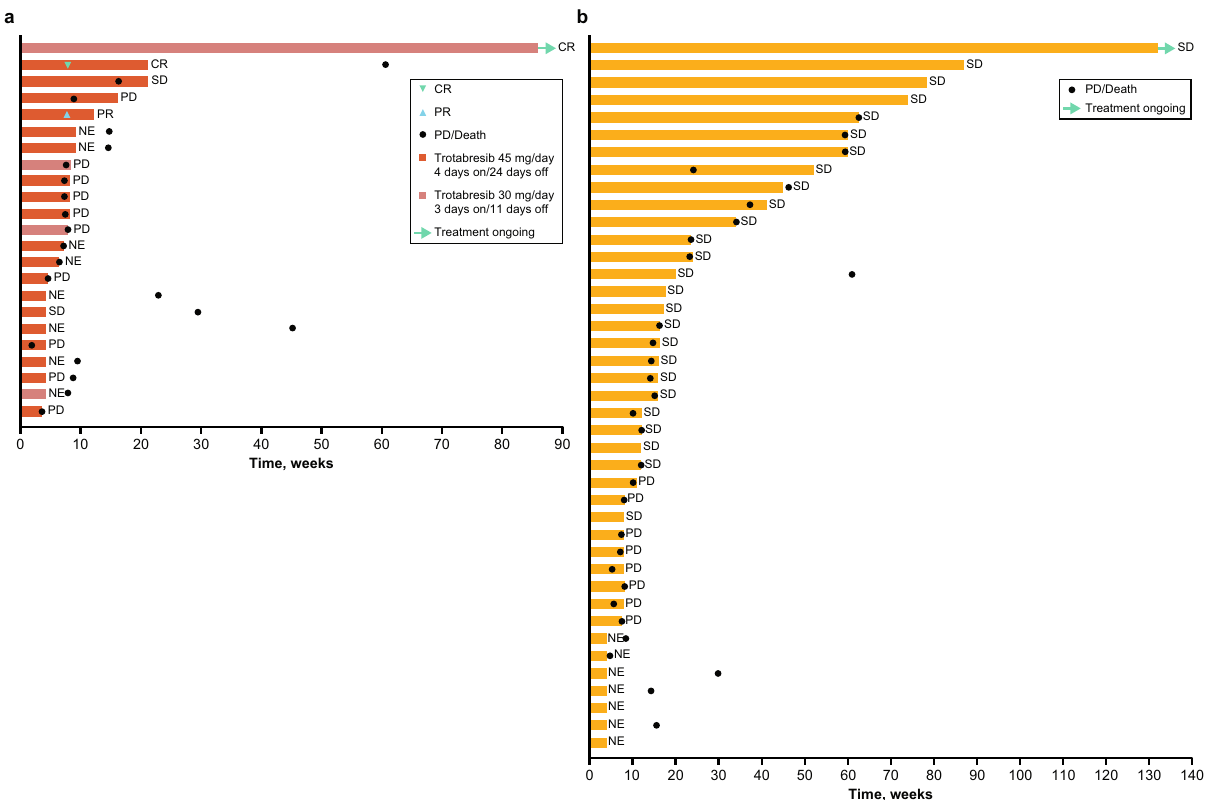
source data fi le. CR complete response, DLBCL diffuse large B-cell lymphoma, NE not evaluable, R/R relapsed/refractory, SD stable disease, PD progressive disease, PR partial